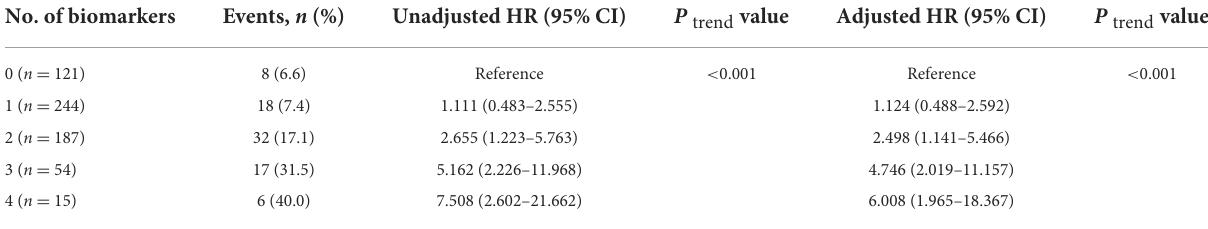
TABLE 4 Multivariable-adjusted HRs (95% CI) of MACE according to the number of elevated biomarkers among ACS patients.